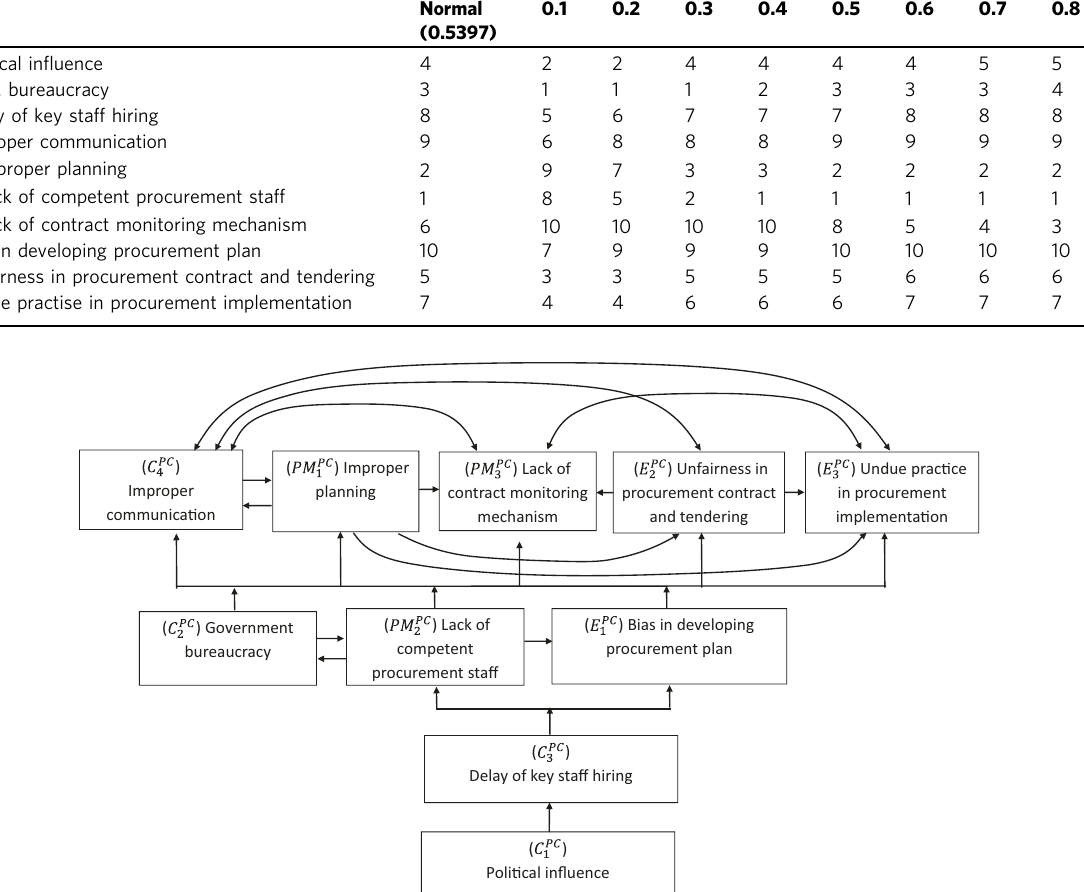
Table 4 Ranking of the challenges obtained from BWM, and sensitivity analysis. PCs Ranking